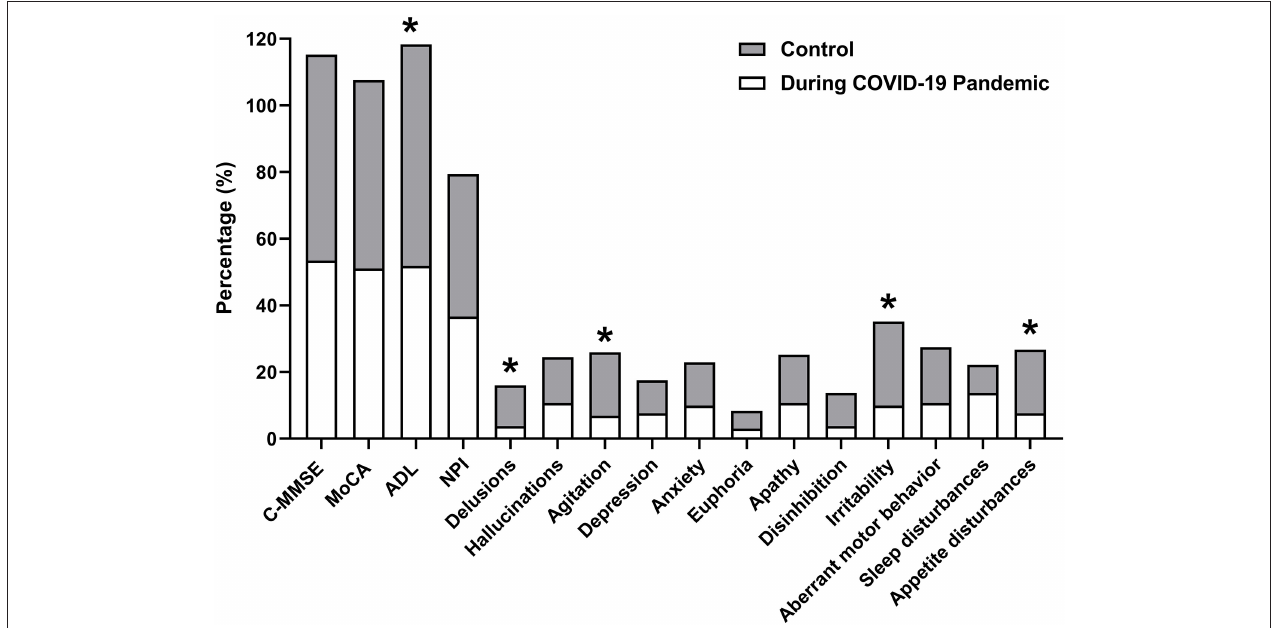
FIGURE 1 | Worsen proportions of cognitive and neuropsychological symptoms during follow-up. The proportions of patients with decreases on the C-MMSE and MoCA scores, and increases on ADL and the NPI (including all items) scores are analyzed and described. C-MMSE, Chinese Mini-Mental State Examination; MoCA, the Montreal Cognitive Assessment; ADL, activities of daily living; NPI, the Neuropsychiatric Inventory. * p <